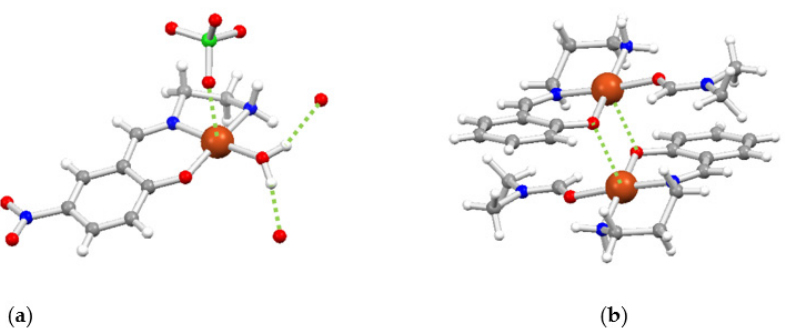
Figure 4. Molecular structures of the solvated species ( a ) [Cu( NO2 L)(H 2 O)](ClO 4 ) · 2H 2 O ( NO2 L – from 5-NO 2 -salH and en, apical Cu ··· O interaction with the perchlorate anion and hydrogen bonds with the co-crystallized water molecules as dashed green lines), CSD/CCDC VOGTUH/684255 [39], and ( b ) [Cu( H L)(dmf)](ClO 4 ) ( H L – from H-salH and tn, dimeric assembly of two cationic species through short Cu ··· O(phenoxido) interactions as dashed green lines), CSD/CCDC ZAWZEE/827358; only one of the two independent molecules is depicted [64]. Reproduction of the structures with Mercury ® 4.3.1 software [71], color code: Cu = orange, O = red, N = blue, C = gray, H = white, perchlorate anions omitted for clarity in ( b